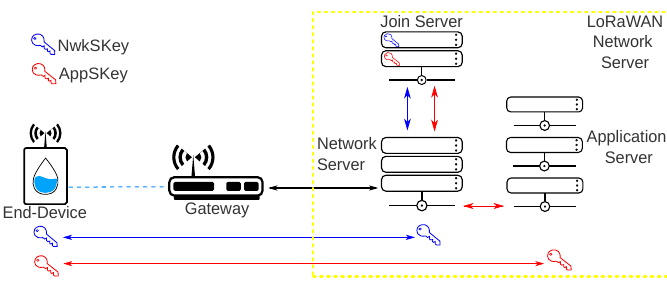
Figure 4. LoRaWAN security architecture.